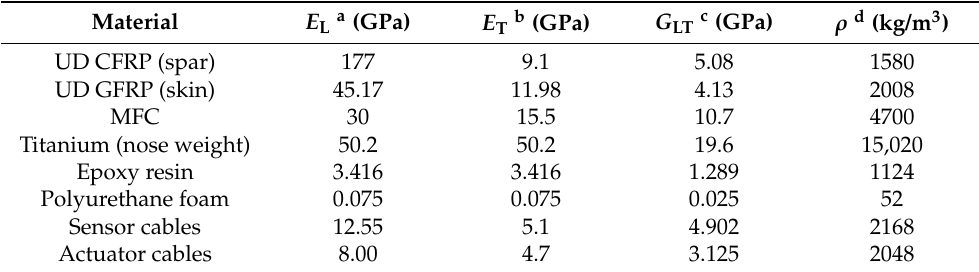
Table 1. Mechanical material